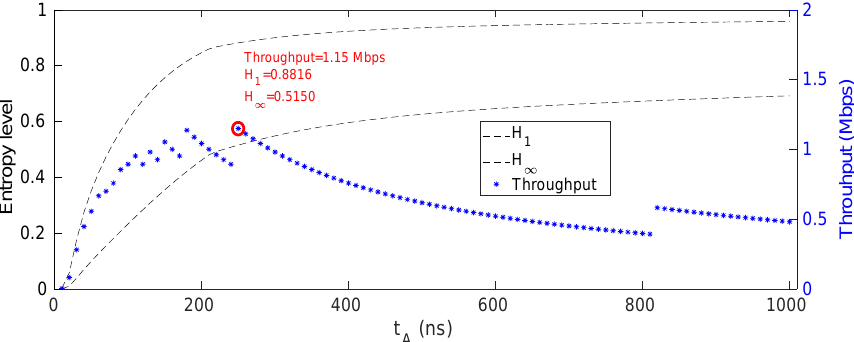
Figure 12: The lower bound estimation for H 1 and H ∞ , the expected throughput after post-processing for different accumulation